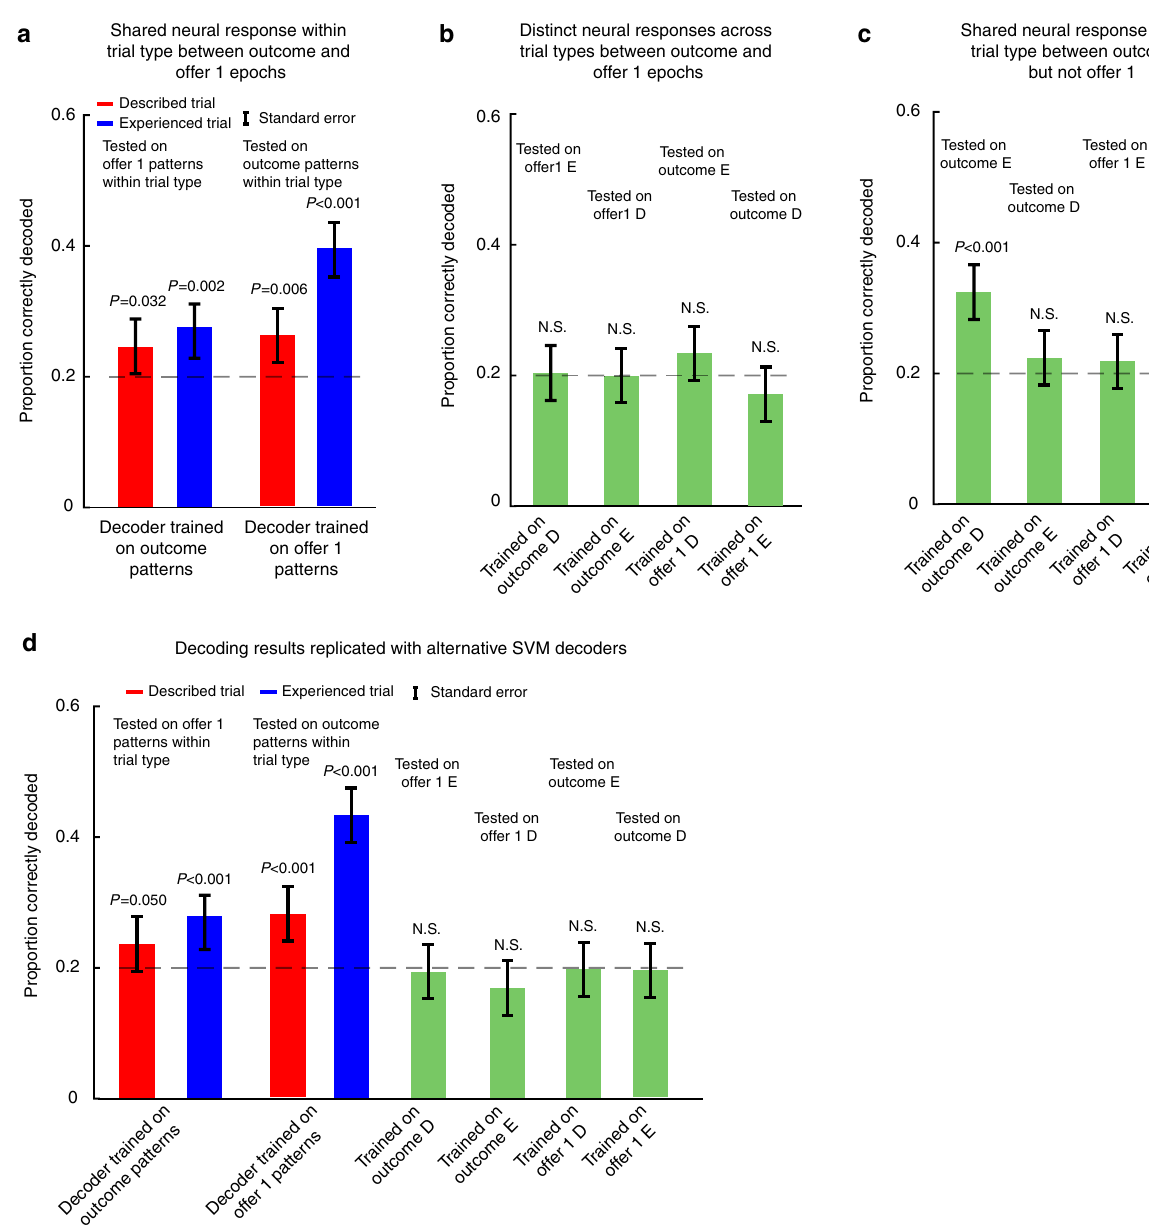
Figure 5 | Decoding Accuracy. D: described trials. E: experienced trials. ( a ) Decoding results indicate reactivation response within each trial type (described or experienced). The decoders trained on population activation states for outcome could successfully decode offer size from neural response patterns associated with offer 1 within each trial type, and vice versa when the decoders were trained on population activation states during offer 1. ( b ) No reactivation response is observed across trial type using decoding approach. ( c ) Neural response patterns for outcomes in described and experienced trials share coding scheme. Neural response patterns for described and experienced offers do not share coding scheme. ( d ) Decoding analyses using Support Vector Machine (SVM) replicate findings in ( a , b ) with neural network